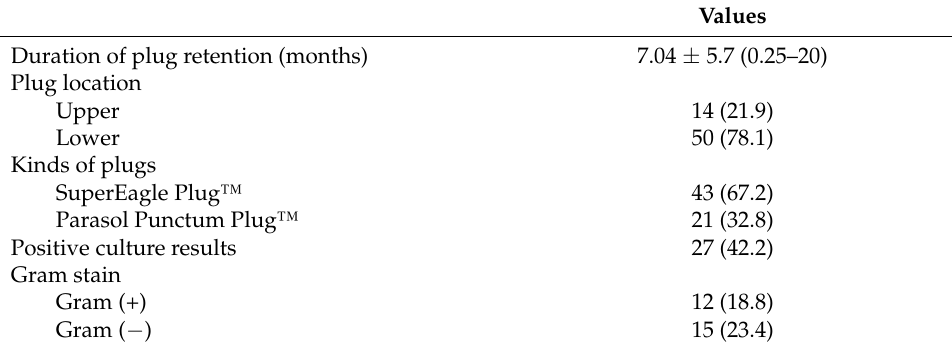
Table 3. Clinical aspects of removed silicone punctal plugs.